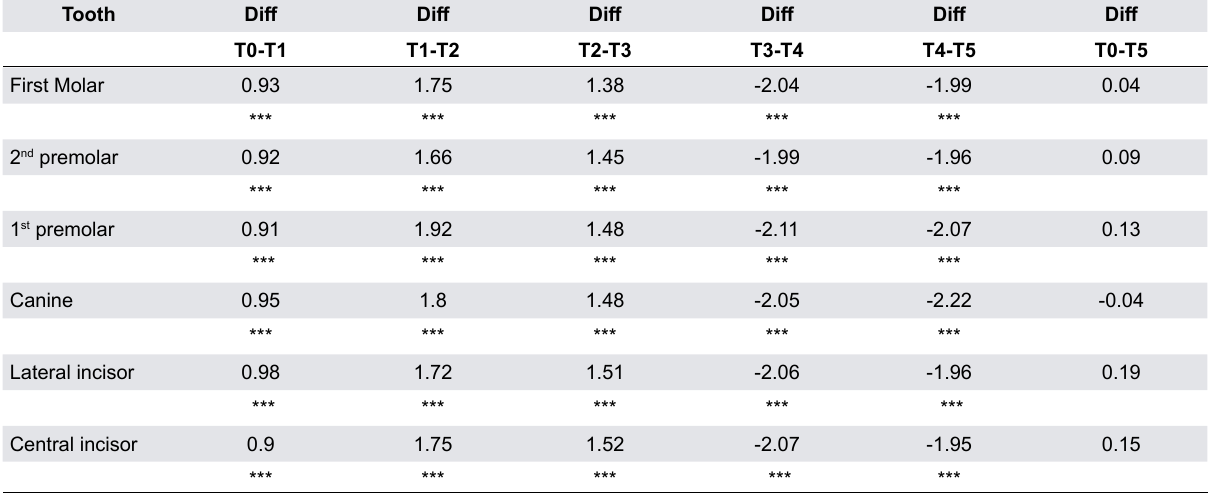
Central incisor